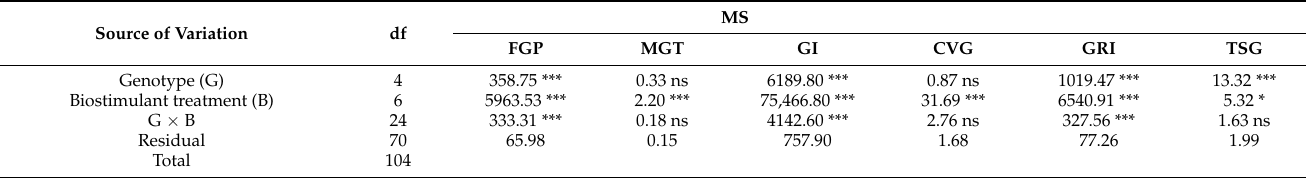
Table 2. Analysis of variance (ANOVA) for the effect of biostimulant and genotype on Abelmoschus esculentus seed germination. FGP, final germination percentage; MGT, mean germination time; GI, germination index; CVG, coefficient of velocity of germination; GRI, germination rate index; TSG, time spread of germination. MS Source of Variation df FGP MGT GI CVG GRI TSG Genotype (G)